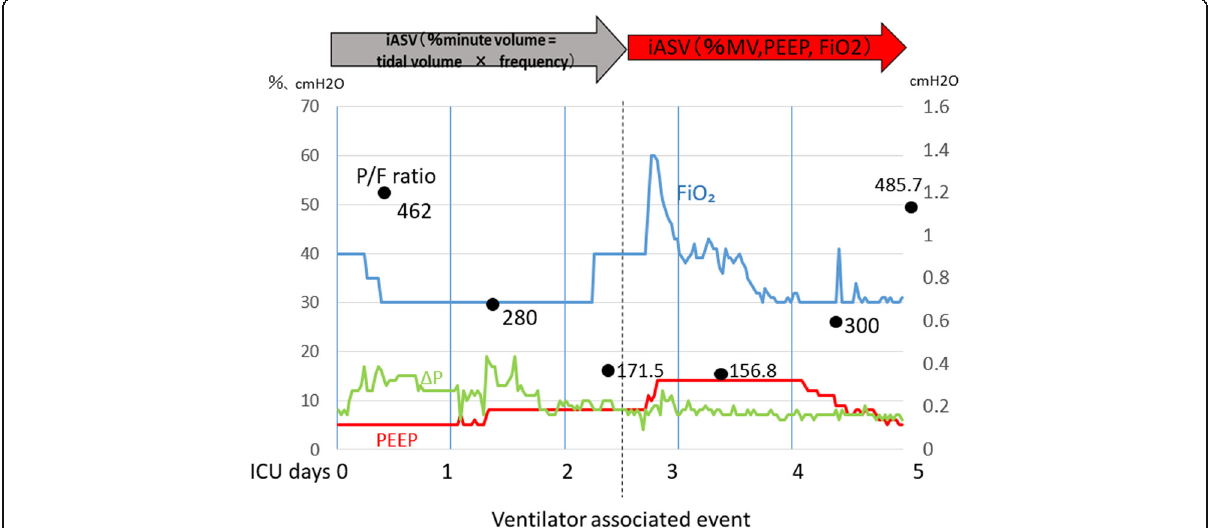
Fig. 2 Progress of iASV. PEEP and FiO 2 were selected as additional automatic settings in iASV, over and above %MV, and continuous ventilation. Using the automatic setting of iASV, PEEP was set at 14 mmHg against the decrease in oxygenation capacity, and FiO 2 and PEEP gradually increased concurrently to reach a FiO 2 value of 0.6. FiO 2 fell notably after recovery of oxygenation capacity, while PEEP gradually decreased after FiO 2 reached 0.3. During this time, the driving pressure ( Δ P ) obtained by subtracting PEEP from the intake plateau pressure was below 10 cm H 2